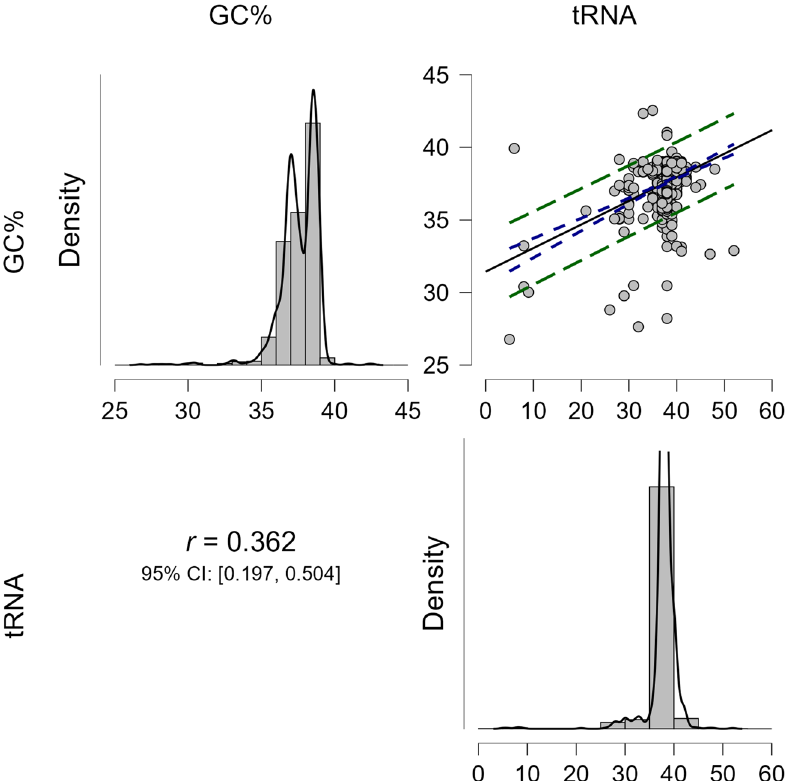
Figure 6. Correlation regression analysis (r = 0.362) of GC % and tRNA gene number in the chloroplast genome. Analysis showed a slight positive correlation between the chloroplast genome’s GC% and tRNA gene number. The analysis was conducted at a p value < 0.05. Correlation analysis was conducted using the JASP 0.16.1.0 version